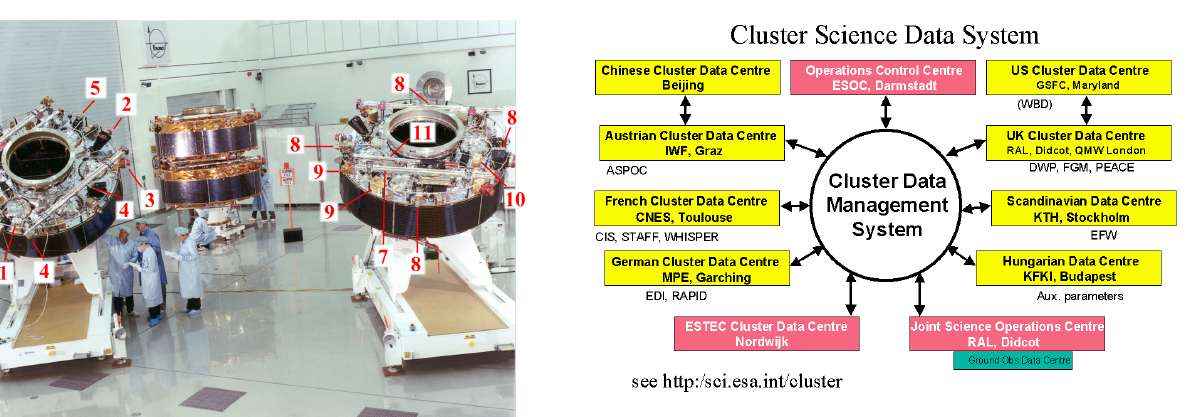
Fig. 3. Position of the 11 instruments on the spacecraft. ASPOC (1), CIS (2), EDI (3), FGM (4), PEACE (5), RAPID (6), DWP (7), EFW (8), STAFF (9), WBD (10), WHISPER (11)